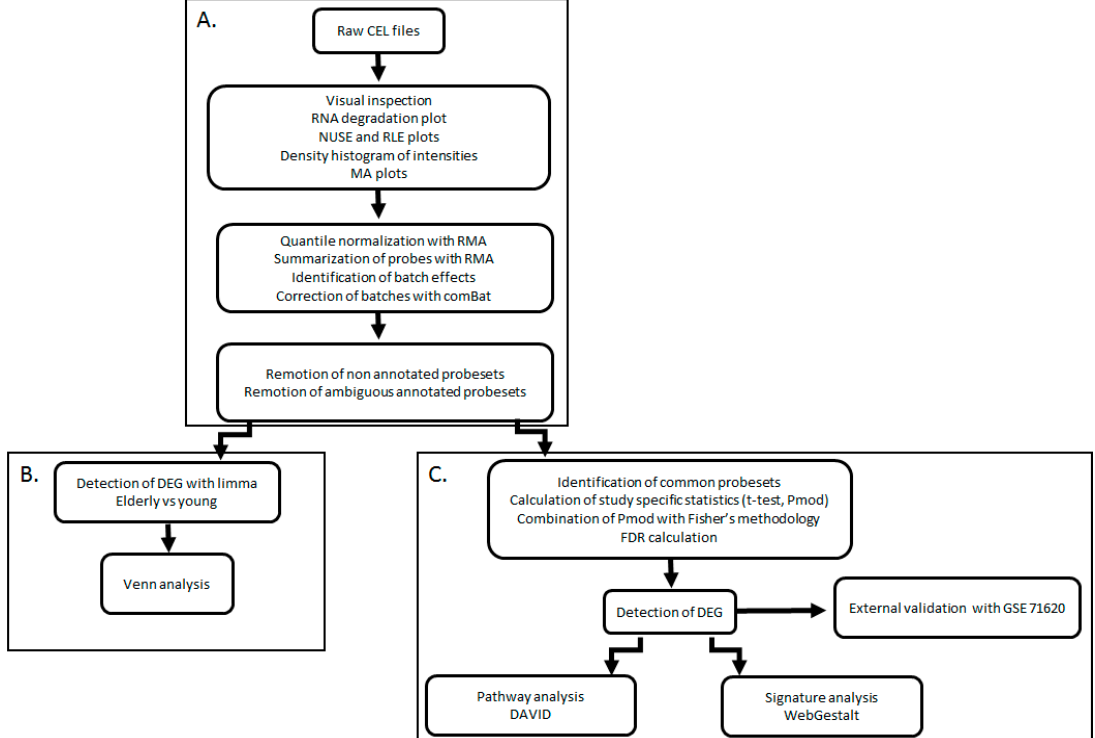
Figure 2. Study workflow. Study was performed in three connected modules. ( A ) Quality control and preprocessing of individual studies. ( B ) Each dataset was analyzed individually using limma and lists of differentially expressed genes (DEGs) were compared by Venn analysis. ( C ) Datasets were combined by meta-analysis. The DEGs were analyzed by pathway over-representation with DAVID and signature analysis was performed using the WebGestalt algorithms. Results of the meta-analysis were validated by comparison with an external dataset (GSE71620).